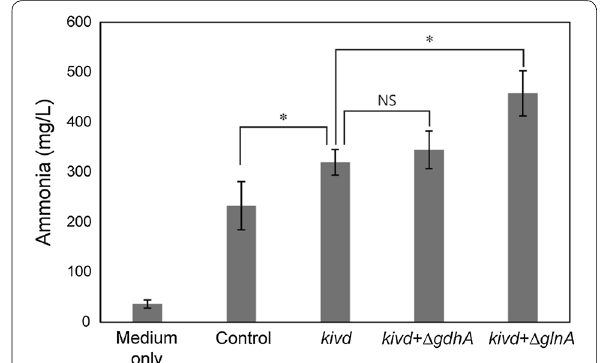
Fig. 4 Ammonia production of modified strains. Values given as